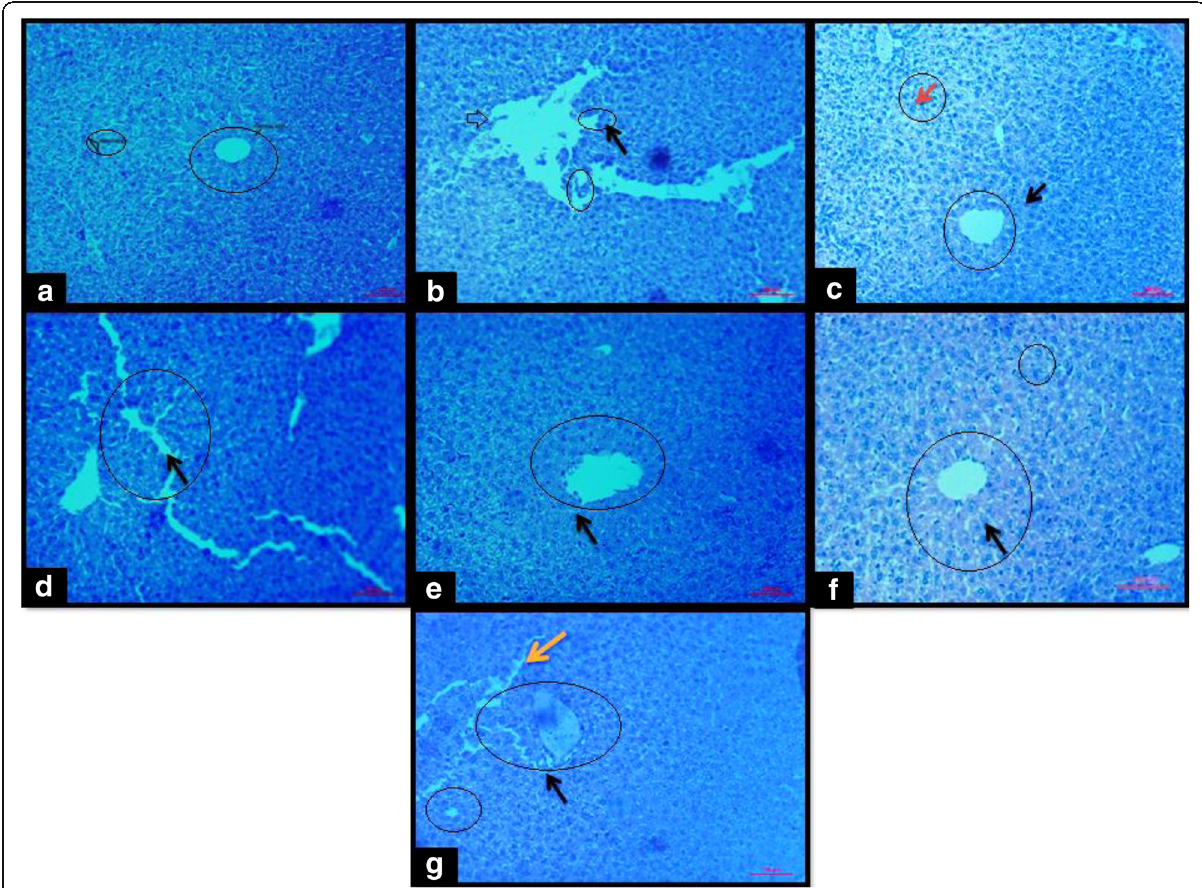
Fig. 5 Histological alteration in the liver (H&E staining 100×) photomicrograph of liver tissue, a . Control b . Only (STZ). c .STZ and Glibenclamide. d . STZ and 0.5%Eucalyptus oil (EO) e . STZ & 1% (EO), f STZ & 1.5% (EO), g . STZ & 2% (EO). Scale bar of 100 μ